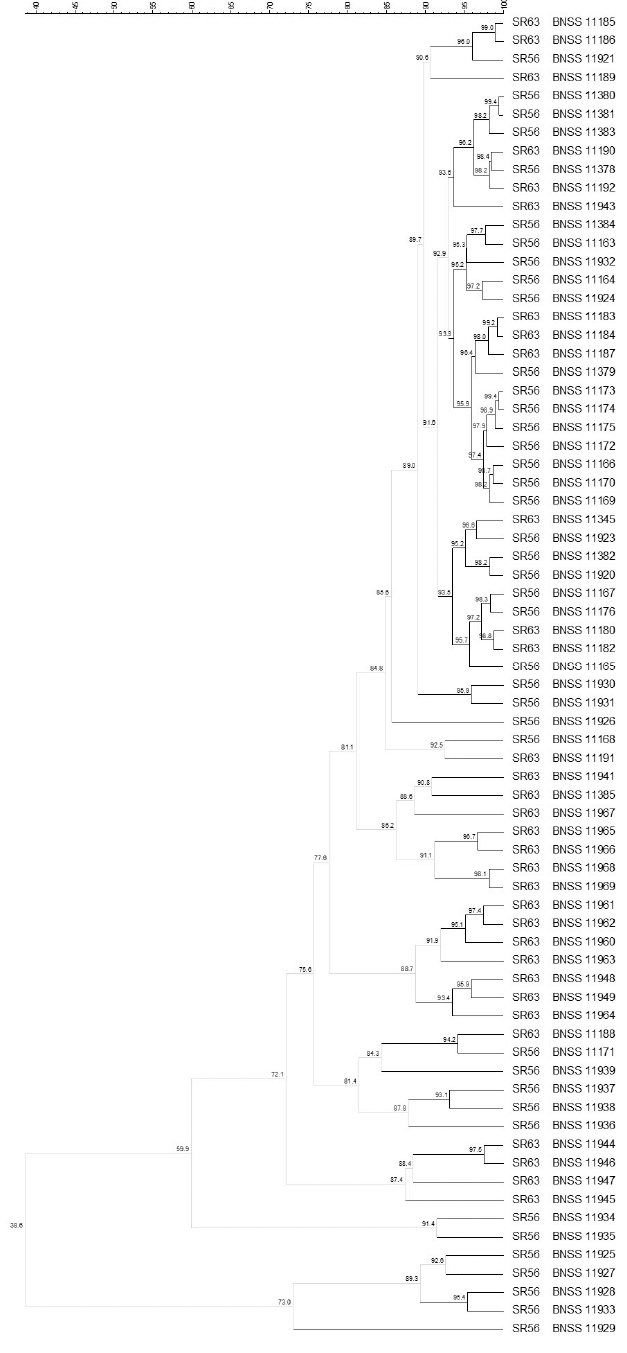
Figure 3. UPGMA cluster analysis, using Pearson correlation, of (GTG) 5 rep-PCR and PFGE elaborated by composite data set comparison tool, of 72 Lactobacillus delbrueckii subsp. lactis isolates from SR56 and SR63 natural cultures. For each isolate, the indication of the culture (56 or 63) and the BNSS ID were reported.